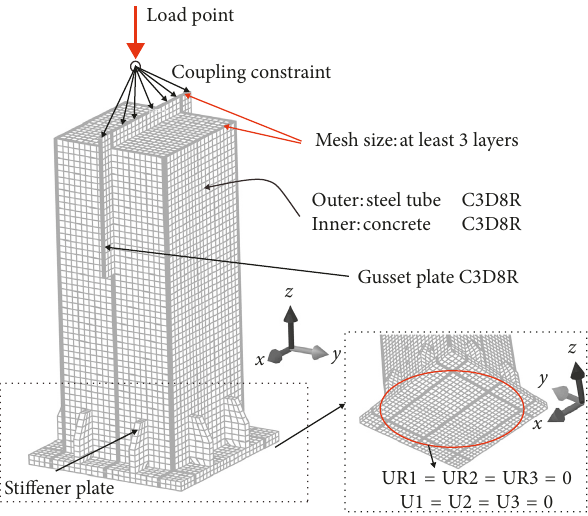
Figure 11: Finite element